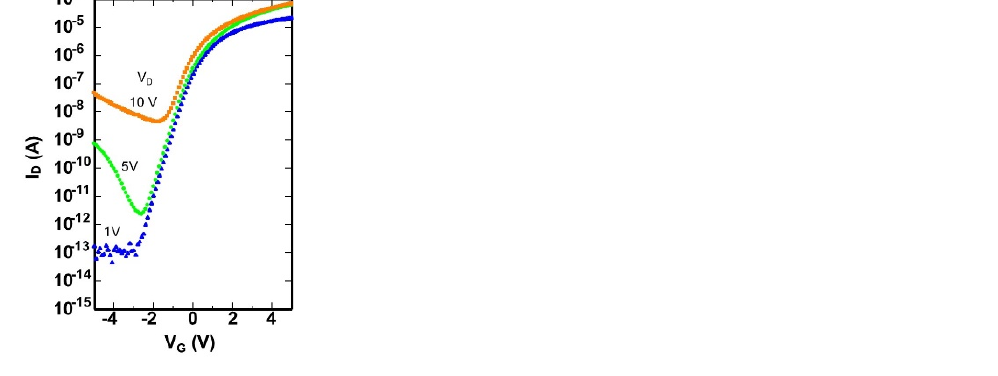
Figure 13. Cumulative distributions of the electrical characteristics in the grained CLC for the par- allel and perpendicular TFTs. ( a ) Effective field-effect mobility, ( b ) threshold voltage Vth , and ( c ) subthreshold swing SS . 3.5. Comparison of Mobility Ratio Fabricated in the Present GB-Free CLC Film with Those in Other CLC Films Figure 14 shows the ratio of the maximum effective mobilities of the perpendicular TFTs to that of the parallel TFTs. This ratio is a figure of merit for mobility isotropy. The TFTs obtained in the present GB-free films show the greatest ratio of 0.95 and a relatively large parallel mobility value of 695 cm 2 /Vs, even with the thin 60 nm thick Si film, as shown in Figure 12. The highest parallel mobility was obtained by the six-times over- lapped CLC on a 150 nm thick Si film [12]; however, the ratio of the TFTs was as low as 0.5 [12] due to the inferior mobility value of the perpendicular TFTs resulting from the existence of the grain boundaries and twin boundaries having a θ > 15°. All the conven- tional CLCs show a ratio of less than 0.5 [9]. The ratio and mobility in the conventional